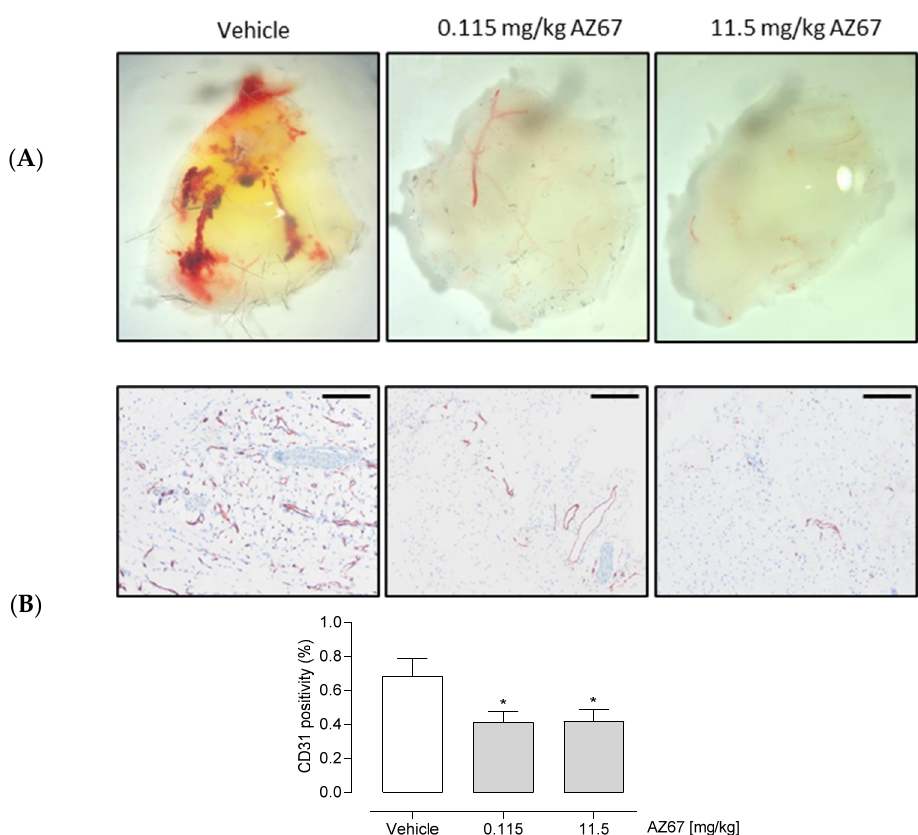
Figure 6. AZ67 inhibits (neo)angiogenesis in vivo. ( A ) Representative macroscopic images of the plugs from the in vivo Matrigel assay. Growth factor reduced Matrigel was mixed with either vehicle, or an equal amount of volume of AZ67 in two different doses: 0.115 mg/kg body weight, and 11.5 mg/kg body weight. The mixture was injected subcutaneously into the flank area of 6-week-old C57BL/6 mice, while under anesthesia. Two weeks after injection the mice were sacrificed, and plugs were harvested for immunohistochemistry processing. ( B ) Top panel: representative macroscopic images of the Matrigel sections. Anti-CD31 antibody was used to delineate ECs. Images were acquired using an Olympus BX43 Microscope. Bottom panel: quantification of CD31 positivity of the microscopic images. Scale bar = 200 µm. * p < 0.05 vs. vehicle (one-way ANOVA, followed by Dunnett test).